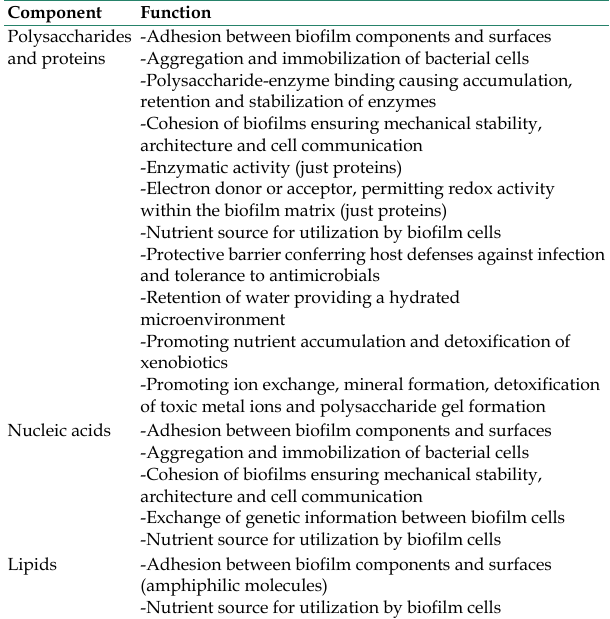
Table 1. Function of major components of extracellular matrix (ECM) in bacterial biofilms, modified from